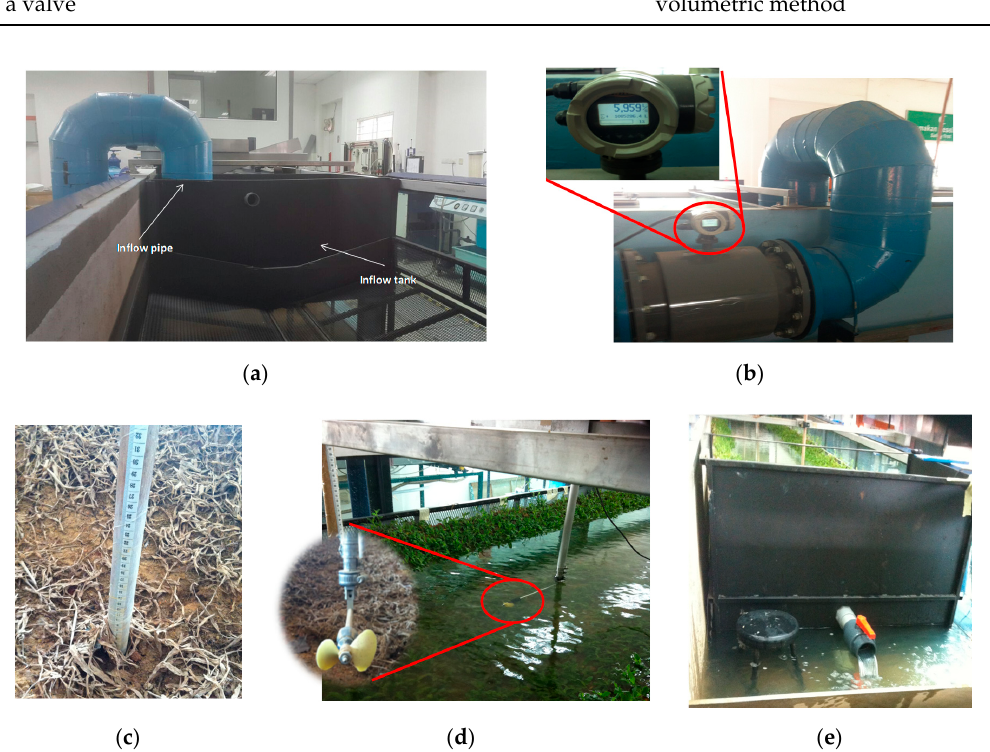
Figure 3. The instruments used in the experiments: ( a ) upstream inflow tank; ( b ) electronic flowmeter; ( c ) staff gage; ( d ) current meter; ( e ) downstream tank with valve. Table 1. The instruments used in the experiments for the measurement of water movements.